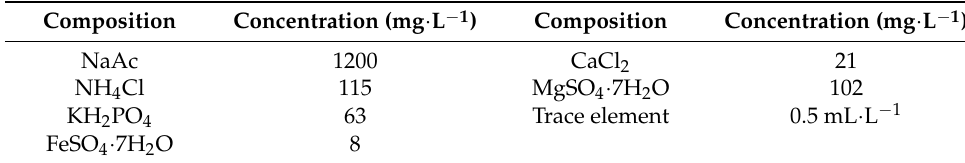
Table 1. Detailed composition of the synthetic wastewater.